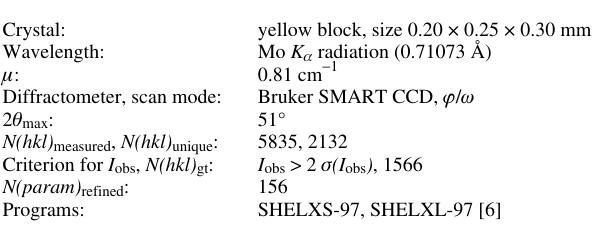
Table 1. Data collection and handling.